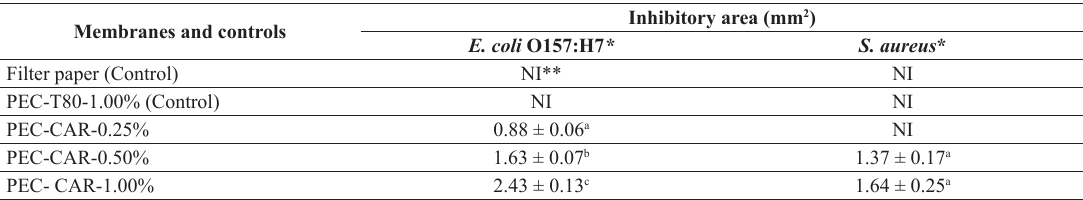
Table 1. Growth inhibition exhibited by E. coli and S. aureus in the presence of CAR-PEC membranes. Membranes and controls